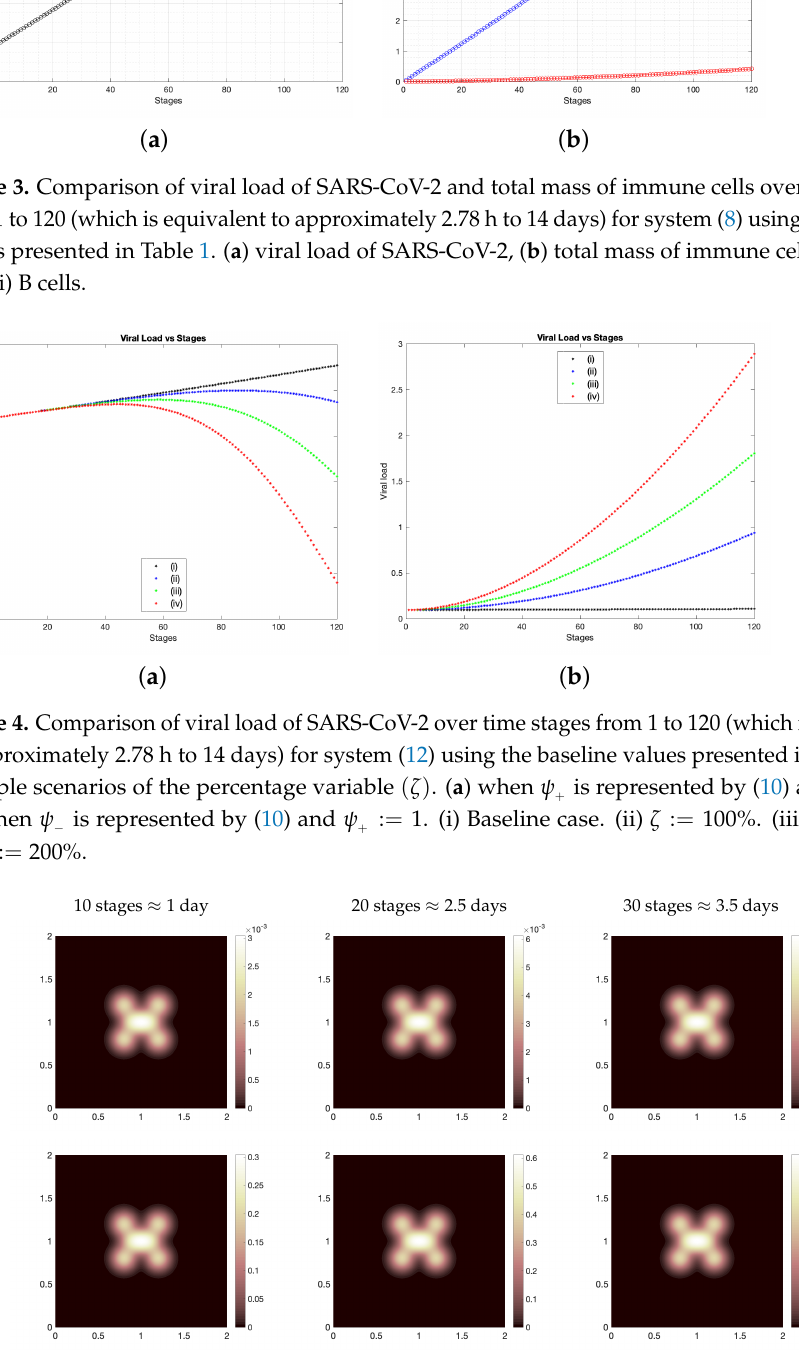
Figure 5. Comparison of spatial distribution of the effector T cells evolution at early stages (10, 20, 30) (which is equivalent to approximately 1, 2.5, 3.5 days). ( a ) Baseline case (a failure of immune responses to SARS-CoV-2). ( b ) example of a better immune responses to SARS-CoV-2, namely, when ψ is represented by (10) and ψ : = 1 ( ζ : = + −